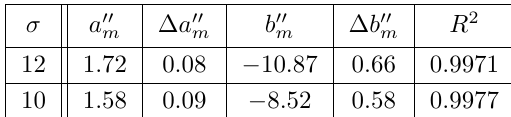
are the uncertainties of parameters , ∆ b 00 m m